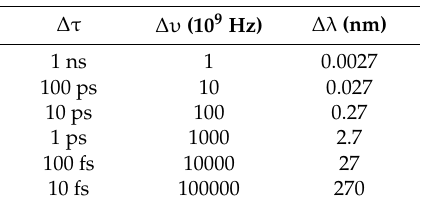
Table 2. Frequency bandwidth, ∆ υ , and wavelength bandwidth, ∆ λ , for pulses of 900 nm center wavelength and durations, ∆ τ , as